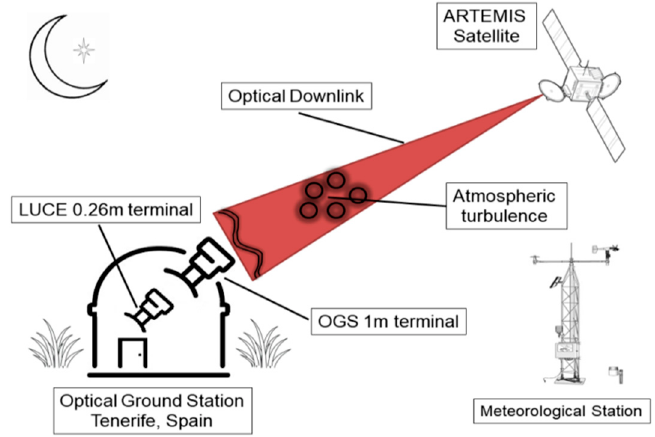
Figure 1. Setup of the ARTEMIS optical experiments.